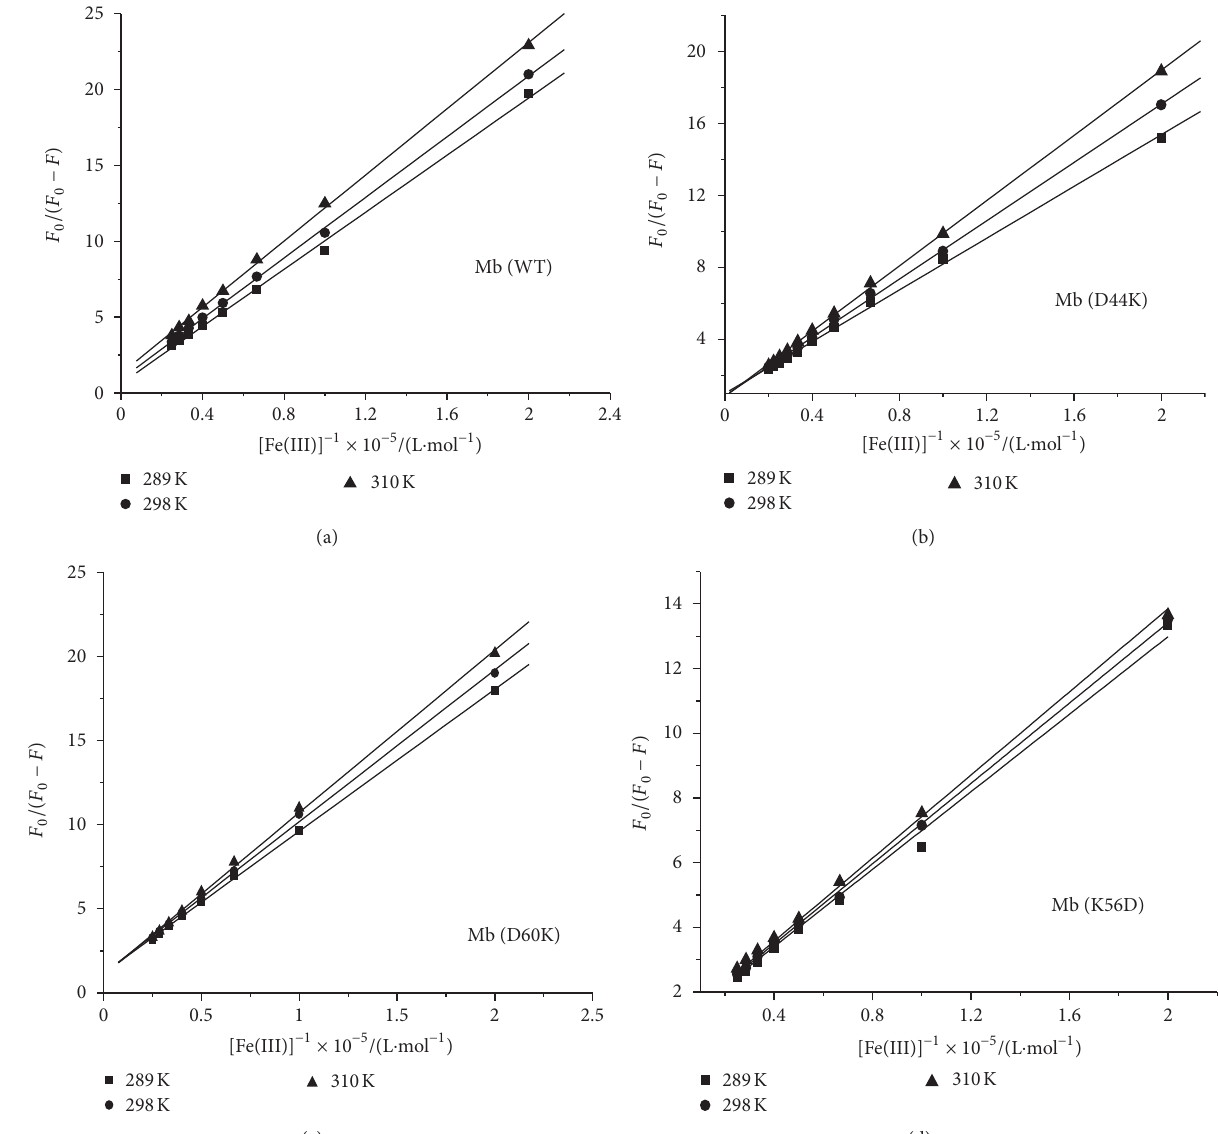
F 4: Lineweaver-Burk plot of Mbs quenched by Fe(III) at different